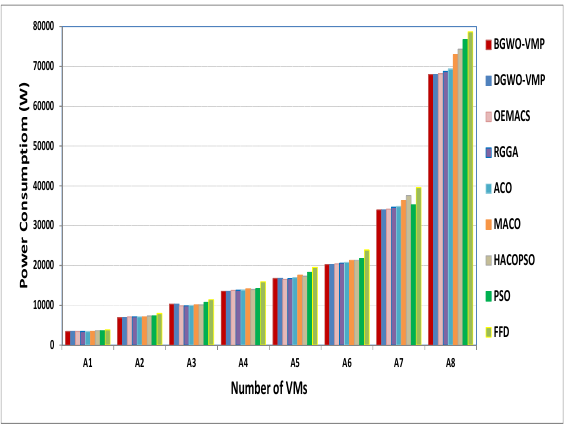
Figure 7. Power consumptions of various algorithms in the homogeneous environment.